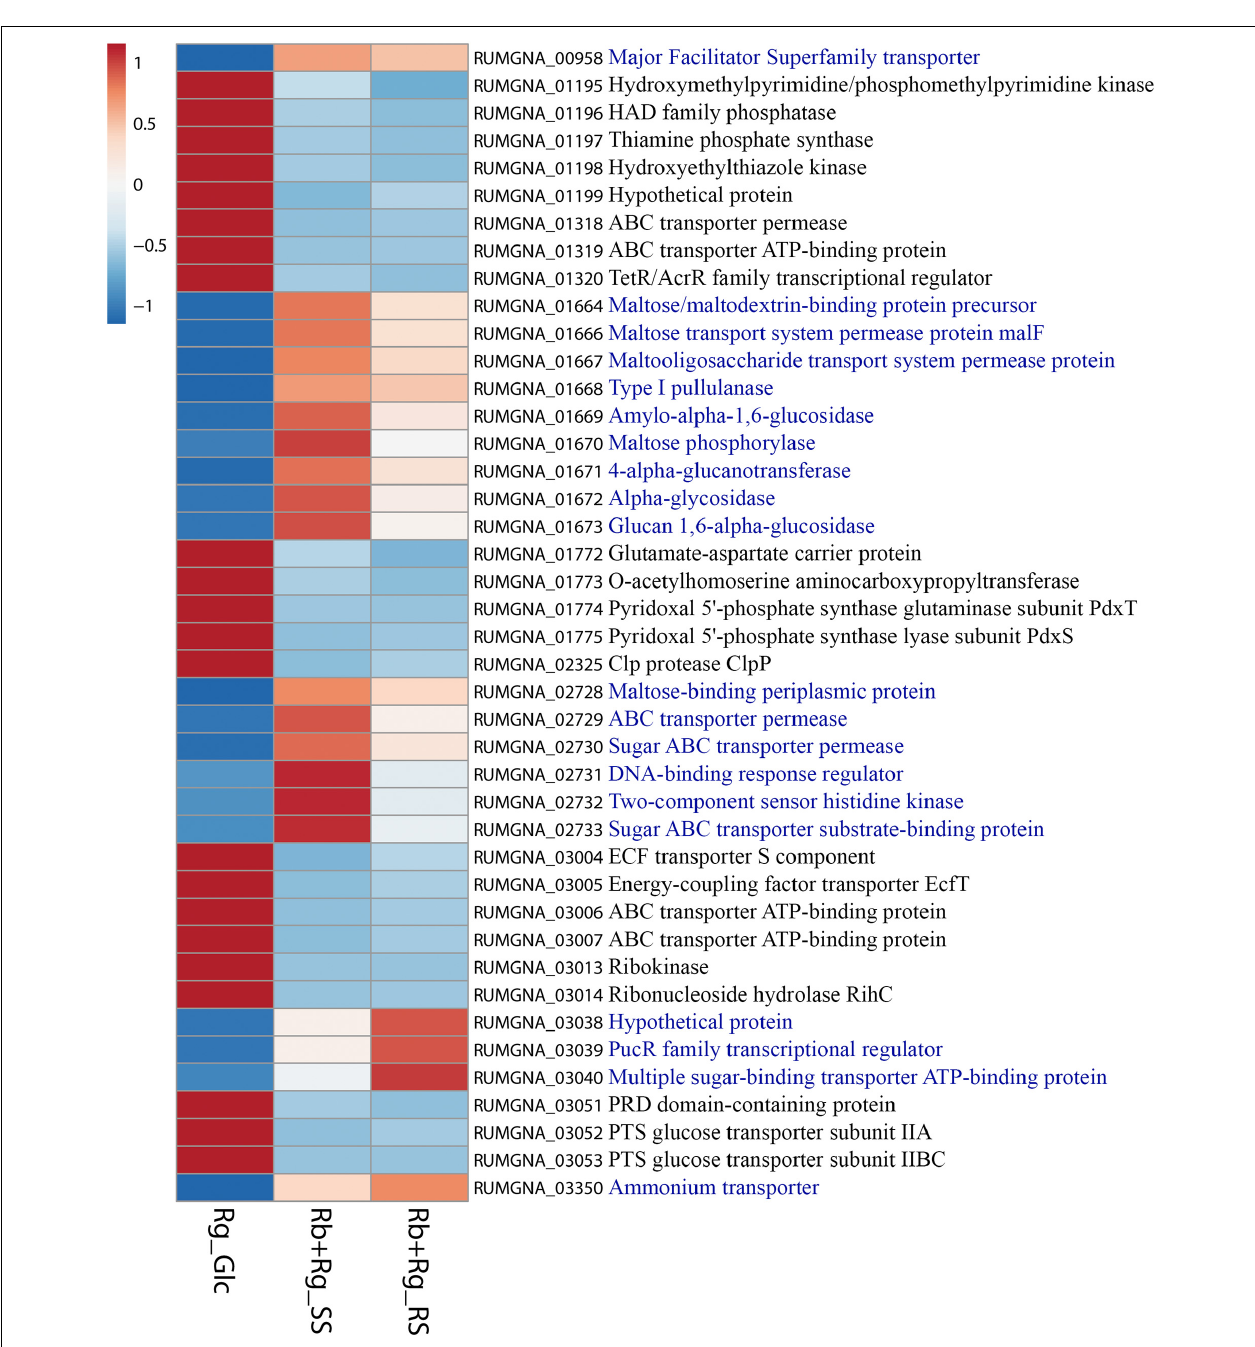
FIGURE 8 | Heatmap of the transcription level (in arbitrary unit) of selected differentially expressed (Log2 Fold Change < –1.5 or > 1.5 and padj < 0.05) R. gnavus ATCC 29149 genes in different growth conditions. This heatmap was produced with ClustVis web tool (Metsalu and Vilo, 2015) using the transcript counts as input values. The 20 R. gnavus ATCC 29149 genes with an upregulated transcription in both co-cultures with R. bromii L2-63 on starch compared to the mono-culture on Glc are in blue. The 22 R. gnavus ATCC 29149 genes with an upregulated transcription in the mono-culture on Glc compared to both co-cultures with R. bromii L2-63 on starch are in